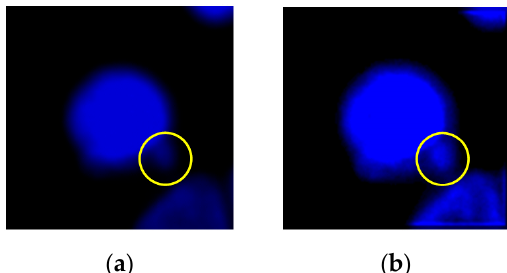
Figure 4. A nucleus with micronuclei (the yellow circle): ( a ) original cell image; ( b ) image enhancement for observation.